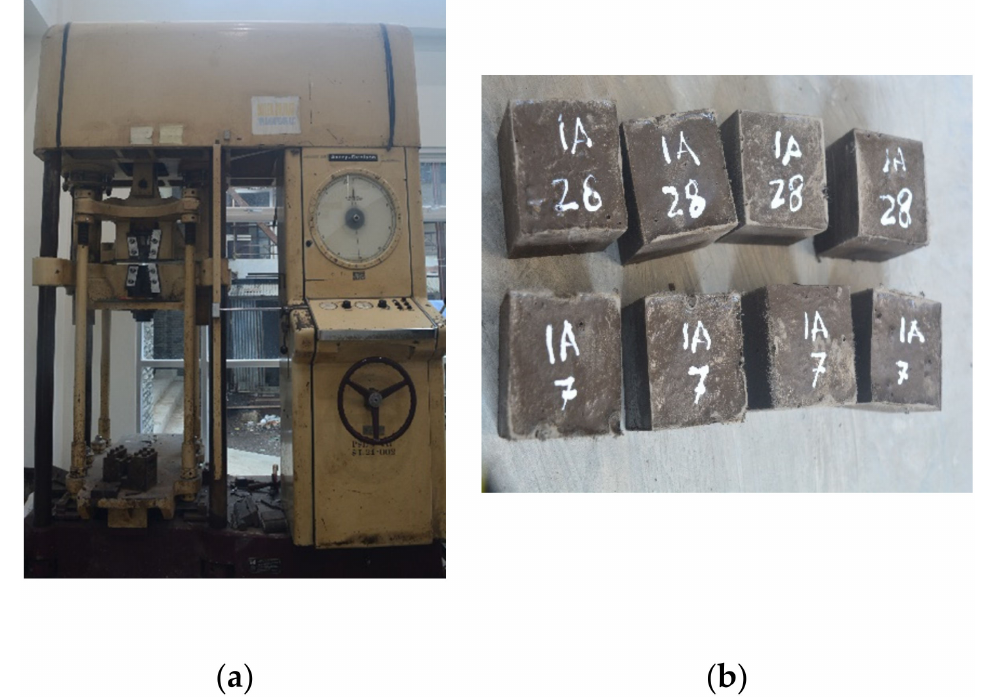
Figure 2. Compressive strength test ( a ) and the specimen ( b ).